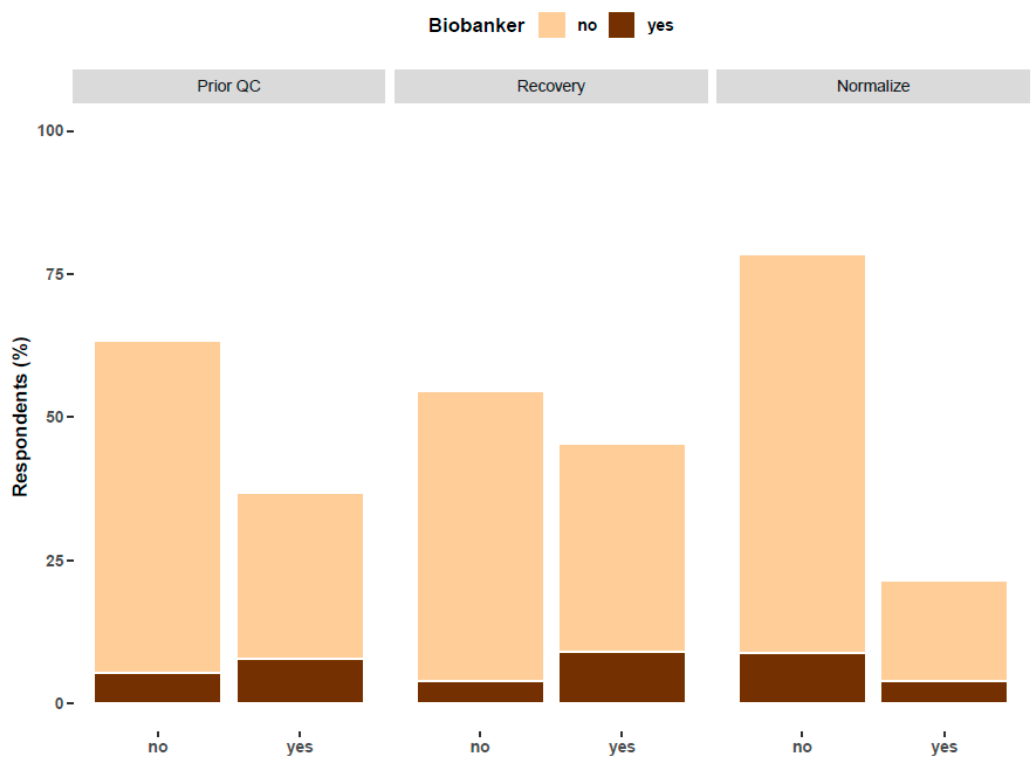
Figure 4. Differences in the application of different quality controls among researchers who prepare samples for biobanks (called “biobankers”) and those who do not. The question referenced as “Prior QC” reads, “Do you perform any form of quality sample control prior to EV separations?” The question referenced as “Recovery” reads, “Do you quantify recovery, specific activity, and/or contaminants in your concentrated or separated EV preparation?” and the question referenced as “Normalize” reads, “Do you normalize EV yield for any possible biological dilution of the biofluid?”. The percentage was calculated over 357, 341 and 326 respondents for each question, respectively.